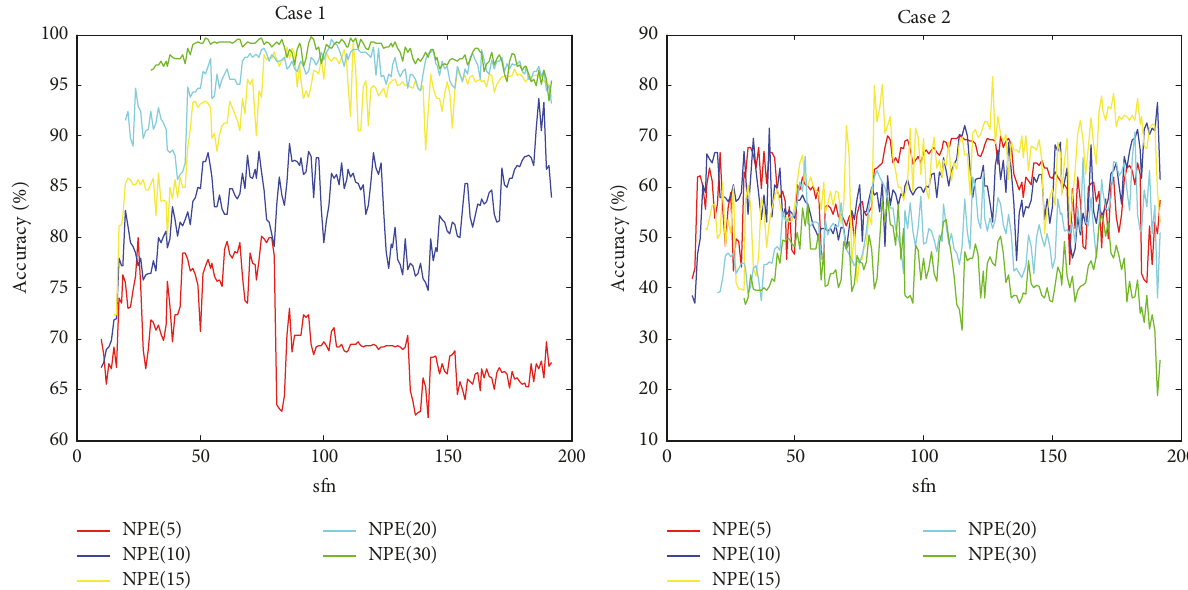
Figure 31: The diagnosis results obtained by OFS-FSASD-NPE-SVM with different number of dimension sizes for NPE. The NPE (5) represents that the number of dimension sizes is